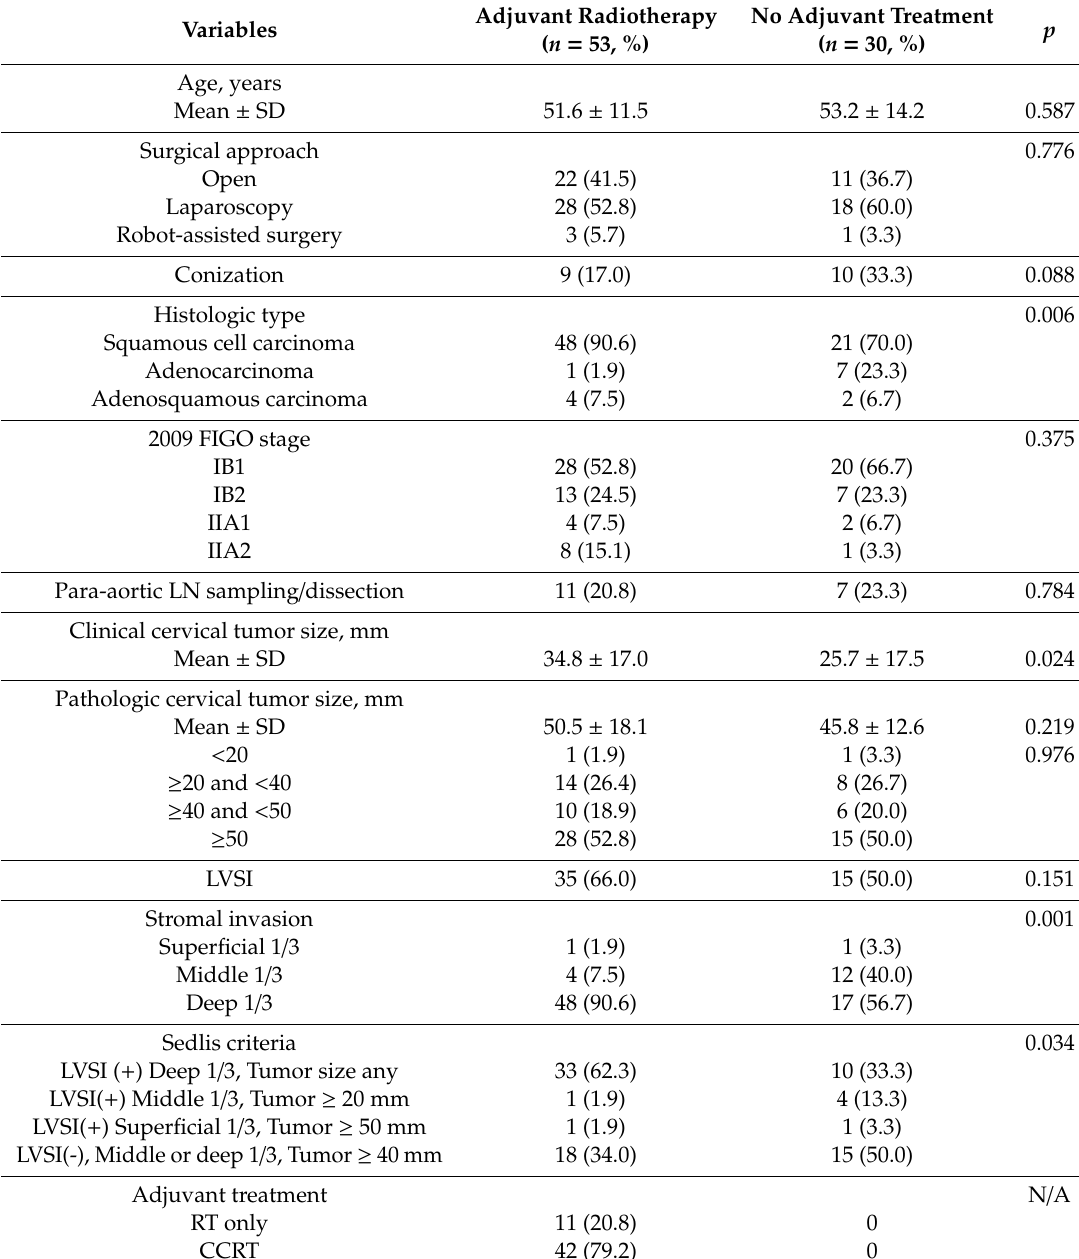
Table 1. Patients’ clinicopathologic